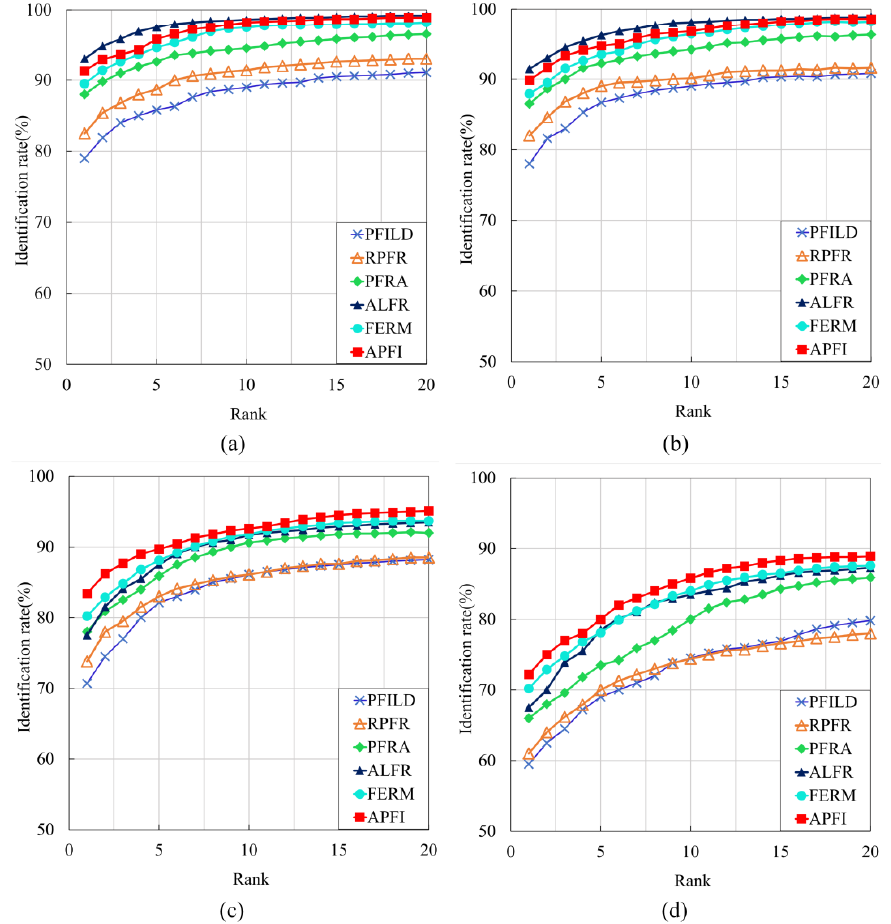
Figure 5. Matching performance of different algorithms on self-built datasets. ( a ) shows the identification performance of different methods on fingerprint images with an effective area of 100%. ( b ) shows the identification performance of different methods on fingerprint images with an effective area of 75%. ( c ) shows the identification performance of different methods on fingerprint images with an effective area of 50%. ( d ) shows the identification performance of different methods on fingerprint images with an effective area of 25%.